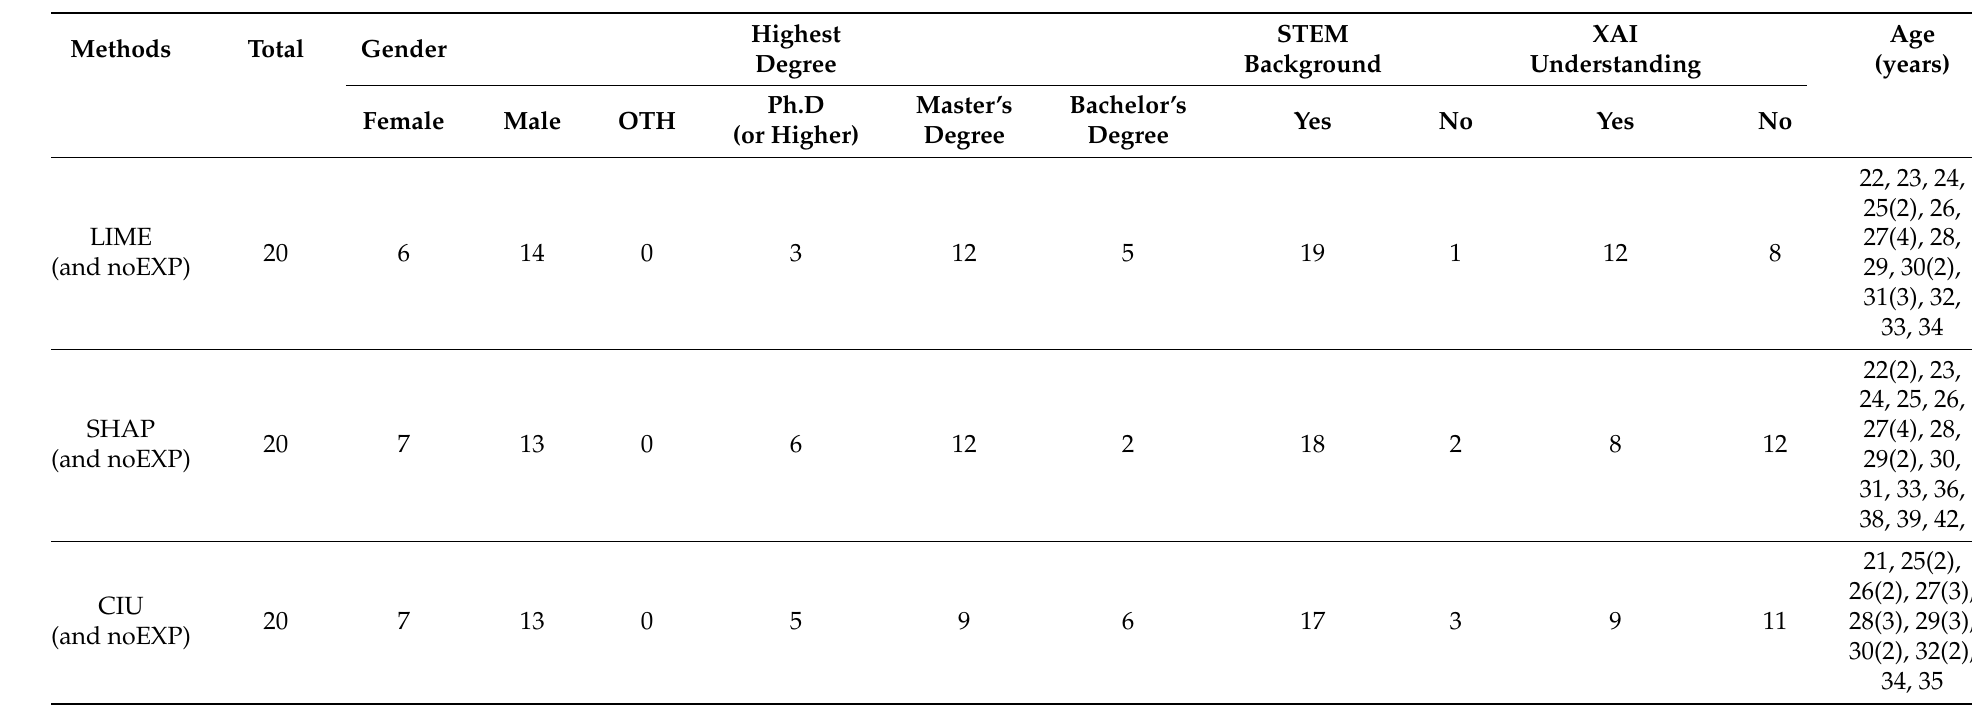
Table 4. Demographics of study participants from LIME, SHAP and CIU user studies (all with included noEXP